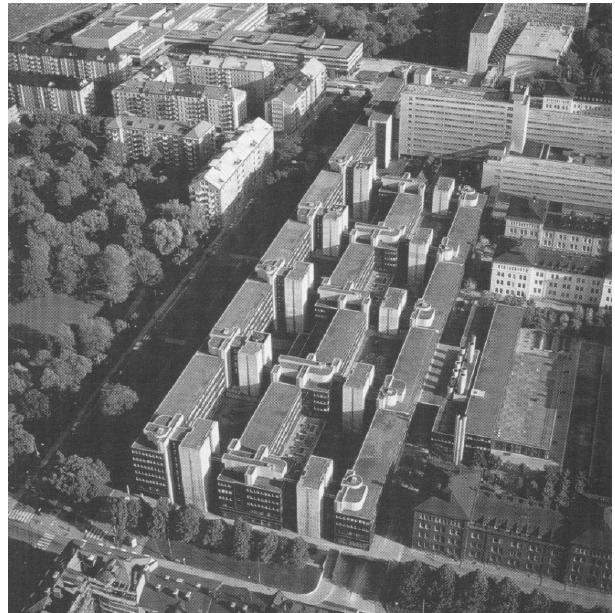
Figure 2. Aerial photo of the block Garnisonen showing the system of staircase towers as “servant spaces”. Photo Coordinator architects.